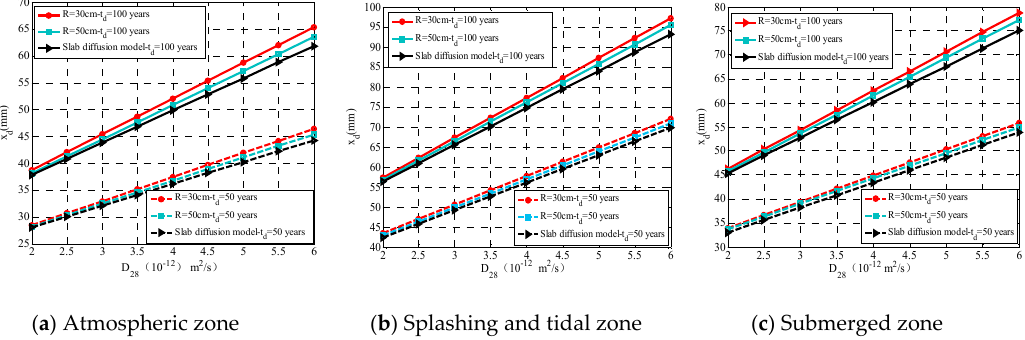
Figure 13. Minimum concrete cover thickness as a function of the 28-day chloride diffusion coefficient in different exposure zones.